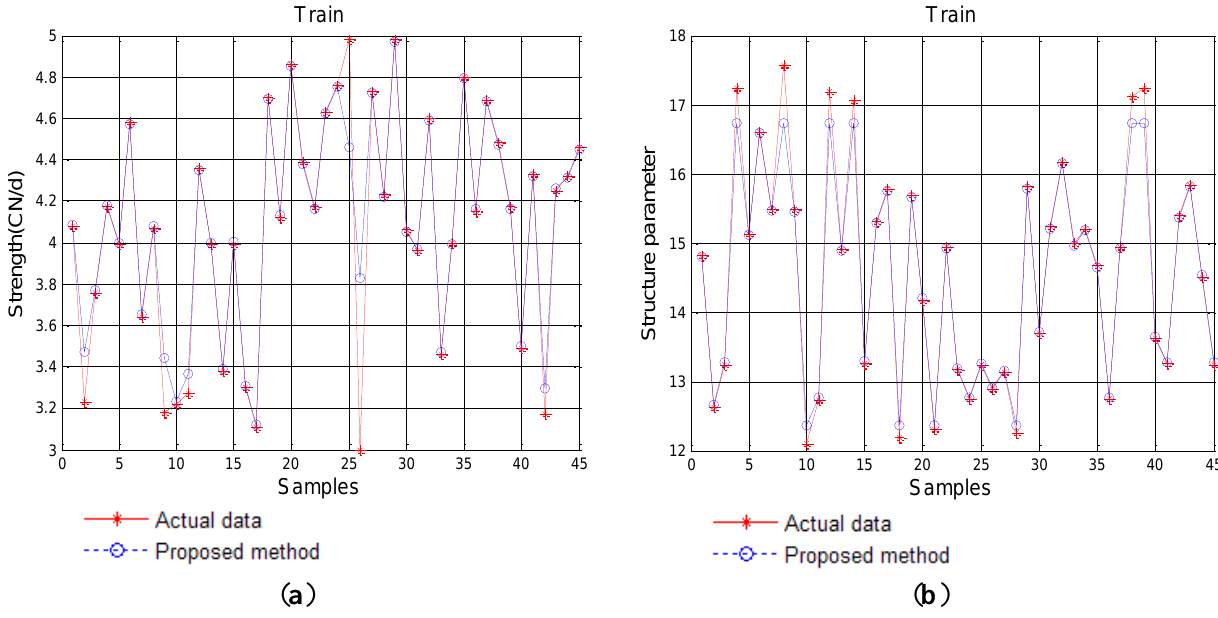
Figure 5. Training results of the proposed SVM-IPSO model. ( a ) Strength; ( b ) Structure